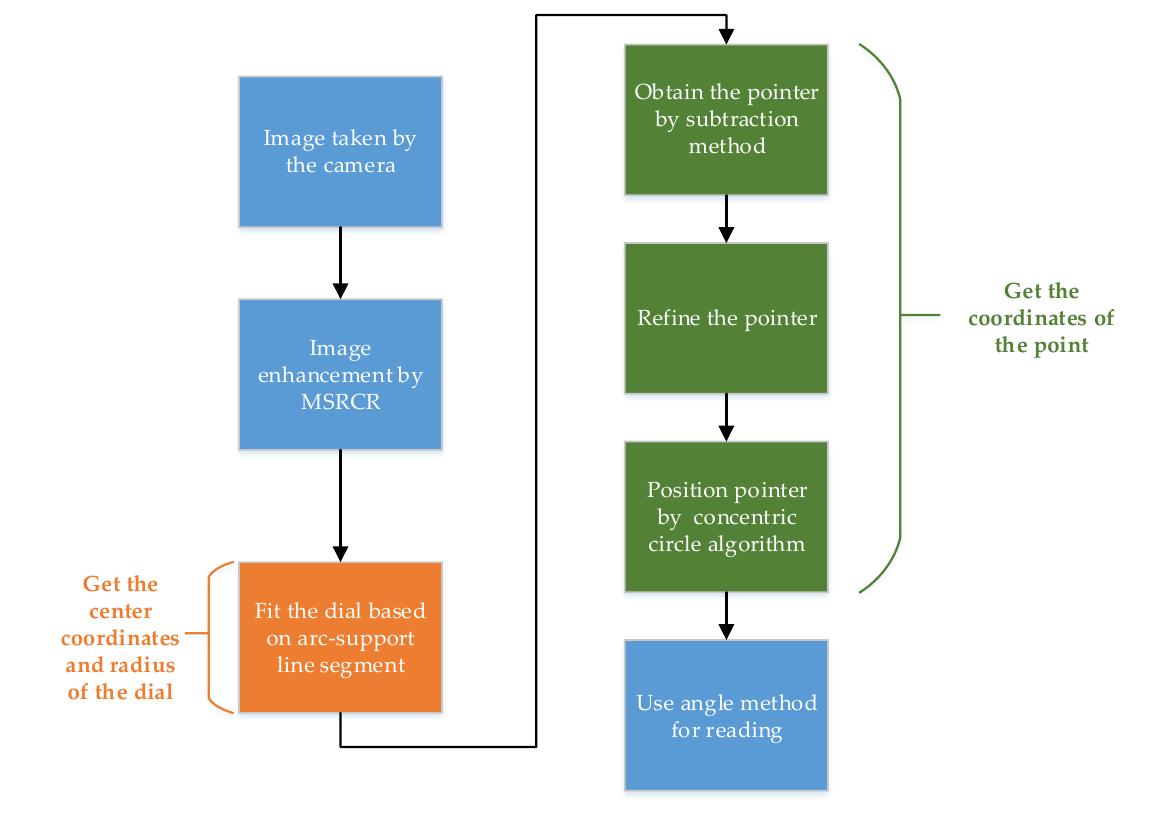
Figure 2. The flow chart of the algorithm.